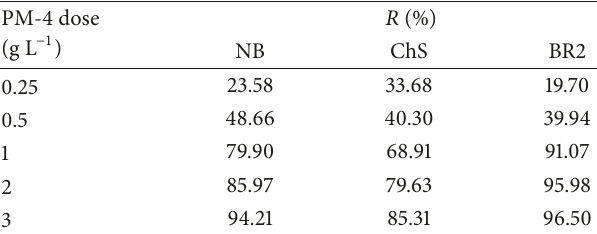
Table 2: Effect of sorbent dose on dyes removal. PM-4